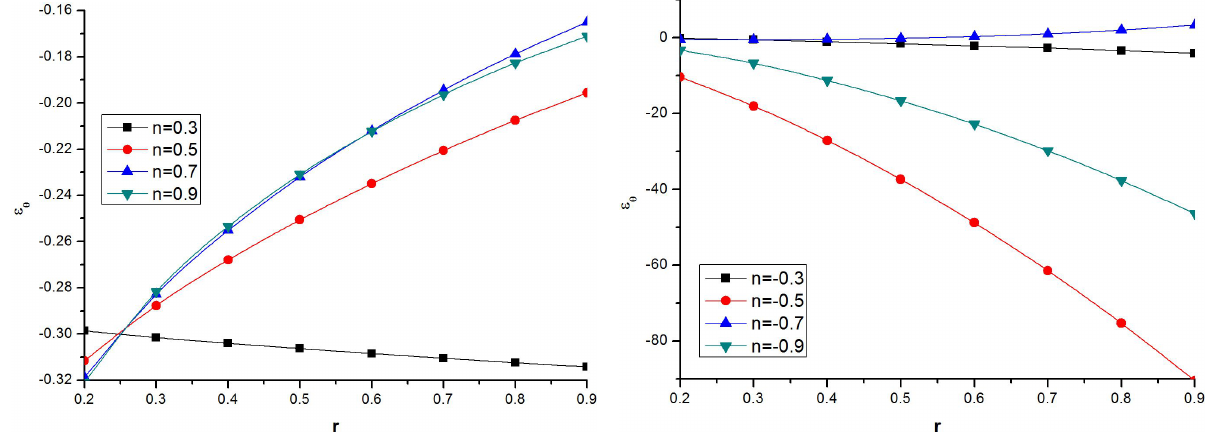
Figure 12: Circumferential stress versus radial coordinate for various values of n under steady state temperate distribution